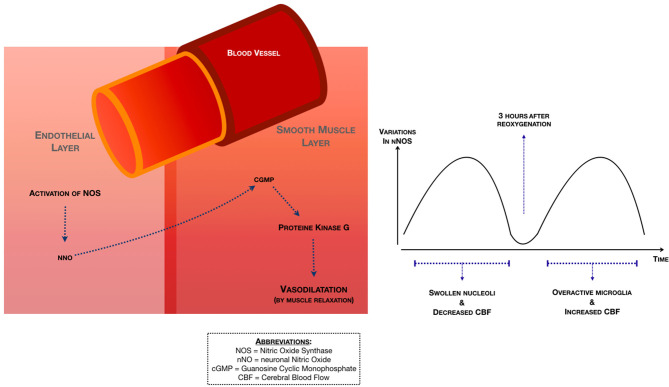
Endogenous pathways associated with NO (14, 41, 42).